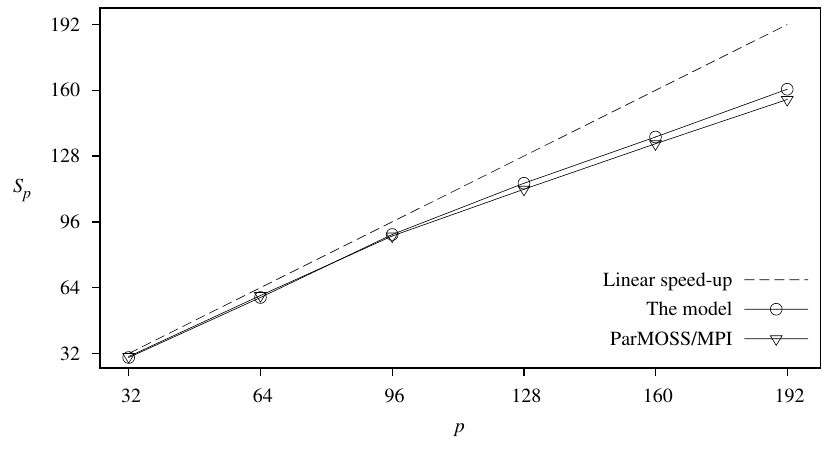
Figure 12. Comparison of the evaluated and the actual speed-up of ParMOSS/MPI on different number of processing units.